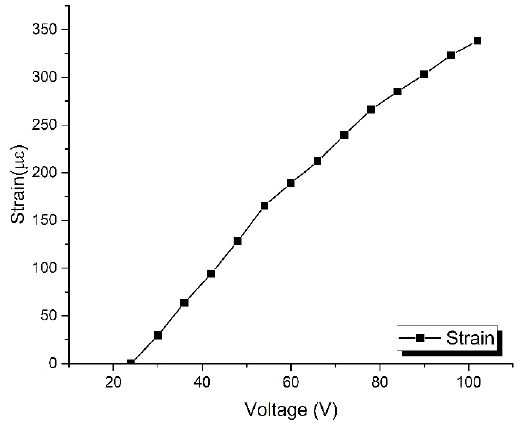
Figure 8. The response of strain to the decrease in controlling voltage.